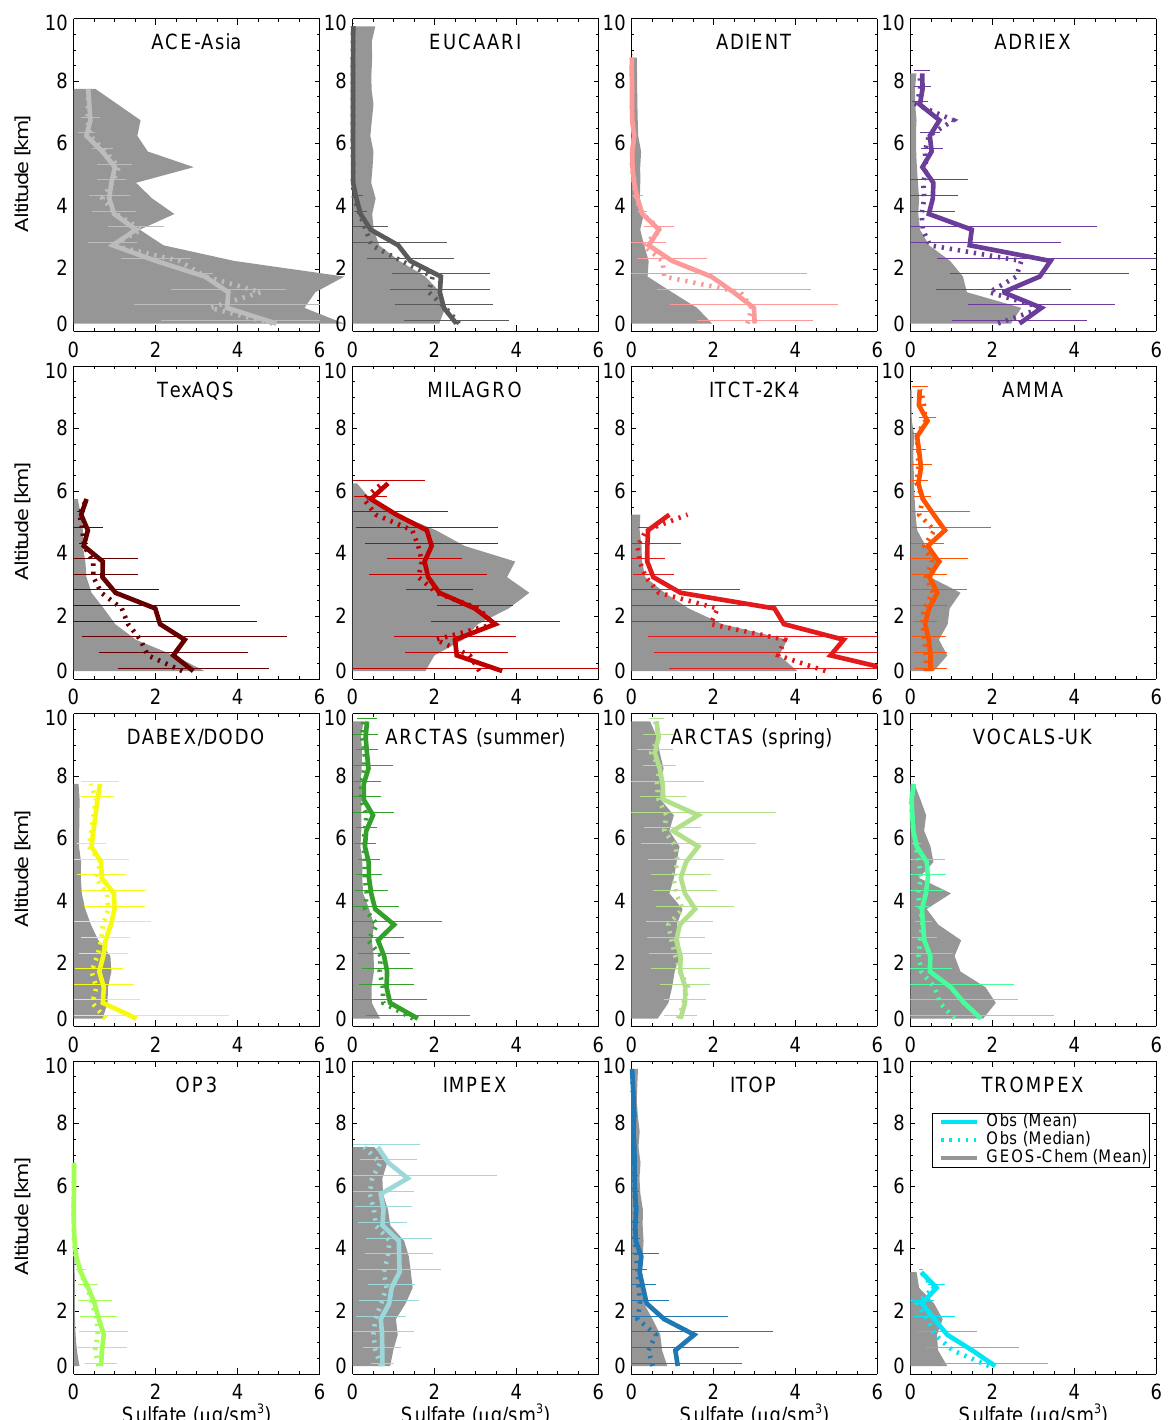
Fig. 4. Mean vertical profile of sulfate for 17 field campaigns (color, solid) with the mean GEOS-Chem simulation shown in grey. The standard deviation of the binned observations at each 0.5km interval are also shown. Median observed values at each altitude are shown as dotted lines. The model simulation is sampled for the dates and locations of each aircraft